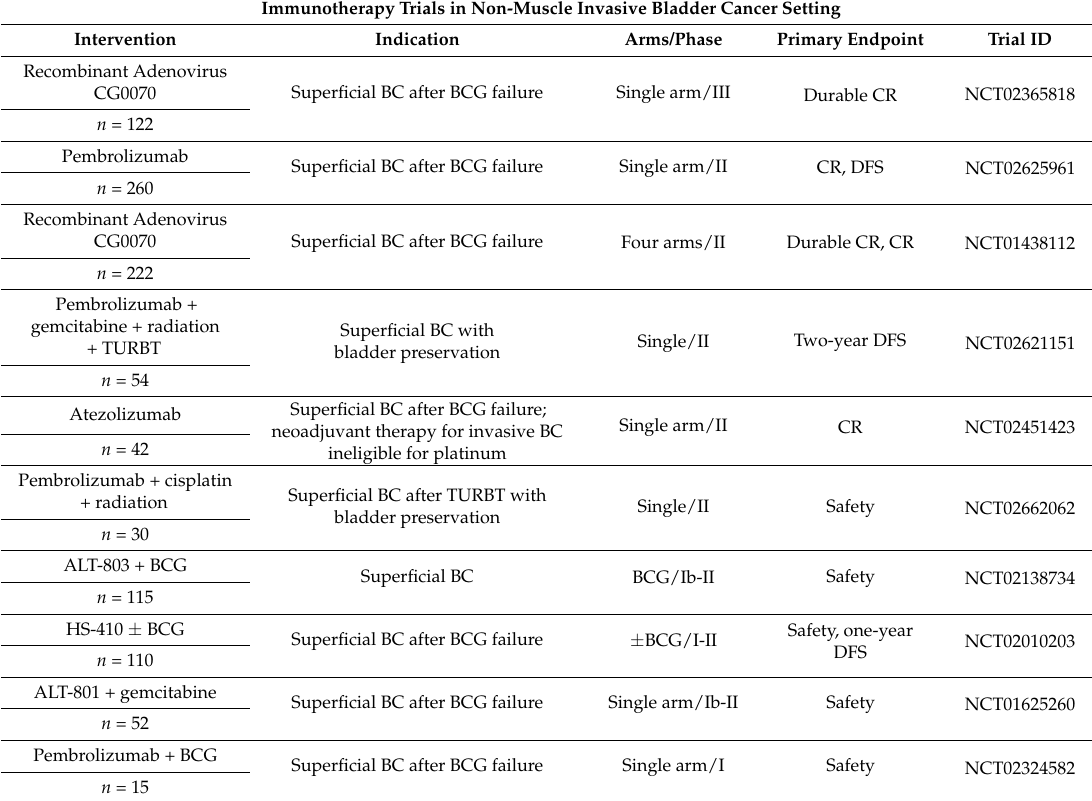
Table 2. Ongoing Immunotherapy trials in Non-Muscle Invasive Bladder